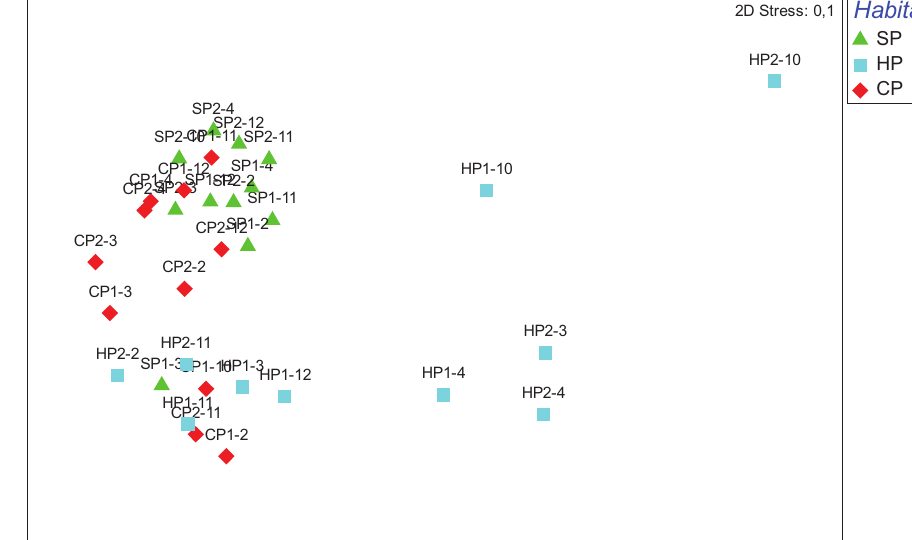
Figure 6. nMDS based on Bray Curtis similarity between samples.